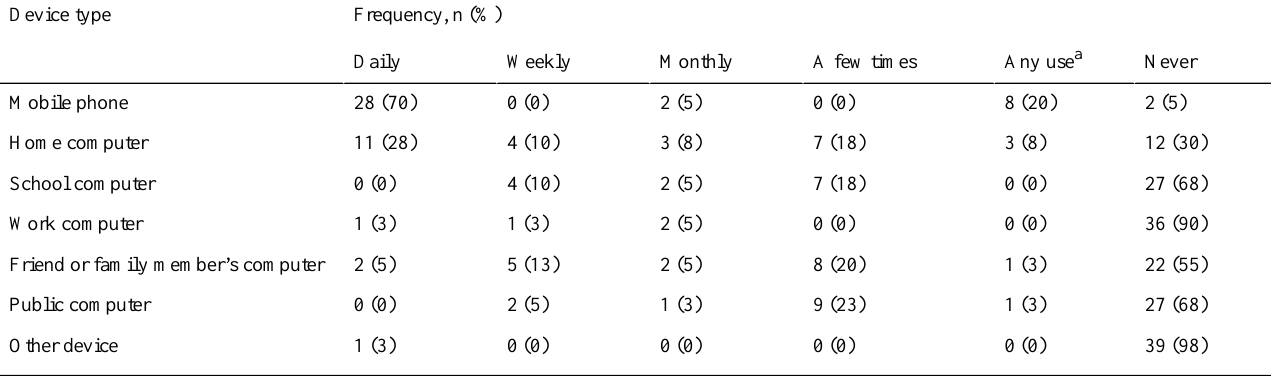
Table 2. Frequency of device use among young adults